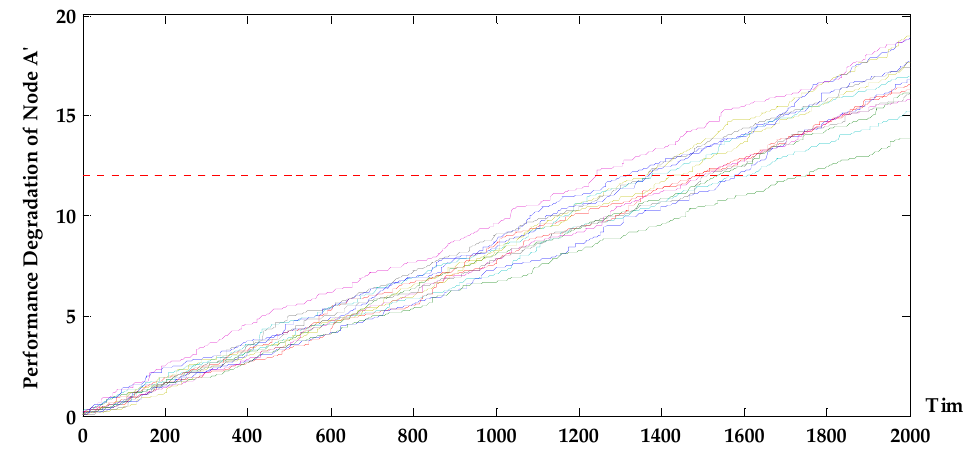
Figure 11. Simulation curve of performance degradation of equipment A (cid:48)